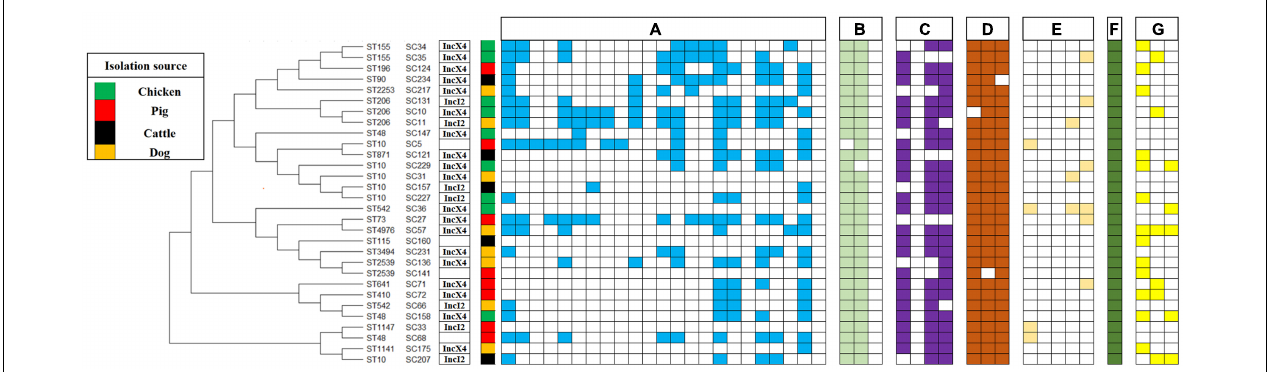
FIGURE 4 | Phylogeny of mcr-1 –positive E. coli (sequence types, strain number, plasmid type, source of isolation, and map of phenotypic resistance and resistance genes). Full and empty square mean presence and absence of antimicrobial resistance (AMR) gene, respectively, whereas empty space means non-defined. (A) Resistance profiles: ampicillin, cefuroxime, ceftazidime, cefepime, ceftriaxone, cefoxitin, aztreonam, ampicillin-sulbactam, amoxicillin-clavulanic acid, gentamicin, amikacin, kanamycin, streptomycin, ciprofloxacin, levofloxacin, tetracycline, doxycycline, tigecycline, chloramphenicol, florfenicol, fosfomycin, sulfisoxazole, and nitrofurantoin. (B) Beta-lactam resistance genes: bla CTX - M , bla TEM and bla SHV . (C) Aminoglycoside resistance genes: strA , strB , aacC2 , and aacC4 . (D) Tetracycline resistance genes: tetA , tetB , and tetC . (E) Fluoroquinolone resistance genes: qnrS , oqxA , oqxB , qepA , and aac(6 (cid:48) )-Ib-cr . (F) Florfenicol resistance gene: floR . (G) Sulfonamide resistance genes: sul1 , sul2 , and sul3